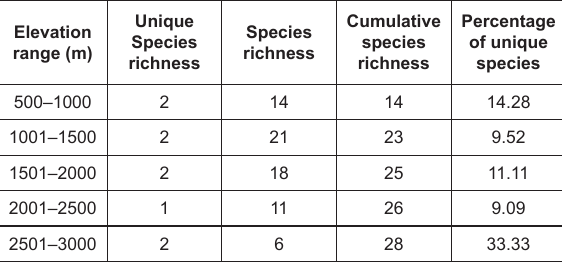
Table 3. Species richness, unique species richness and cumulative species richness of Chiroptera in five elevation zones of Himachal